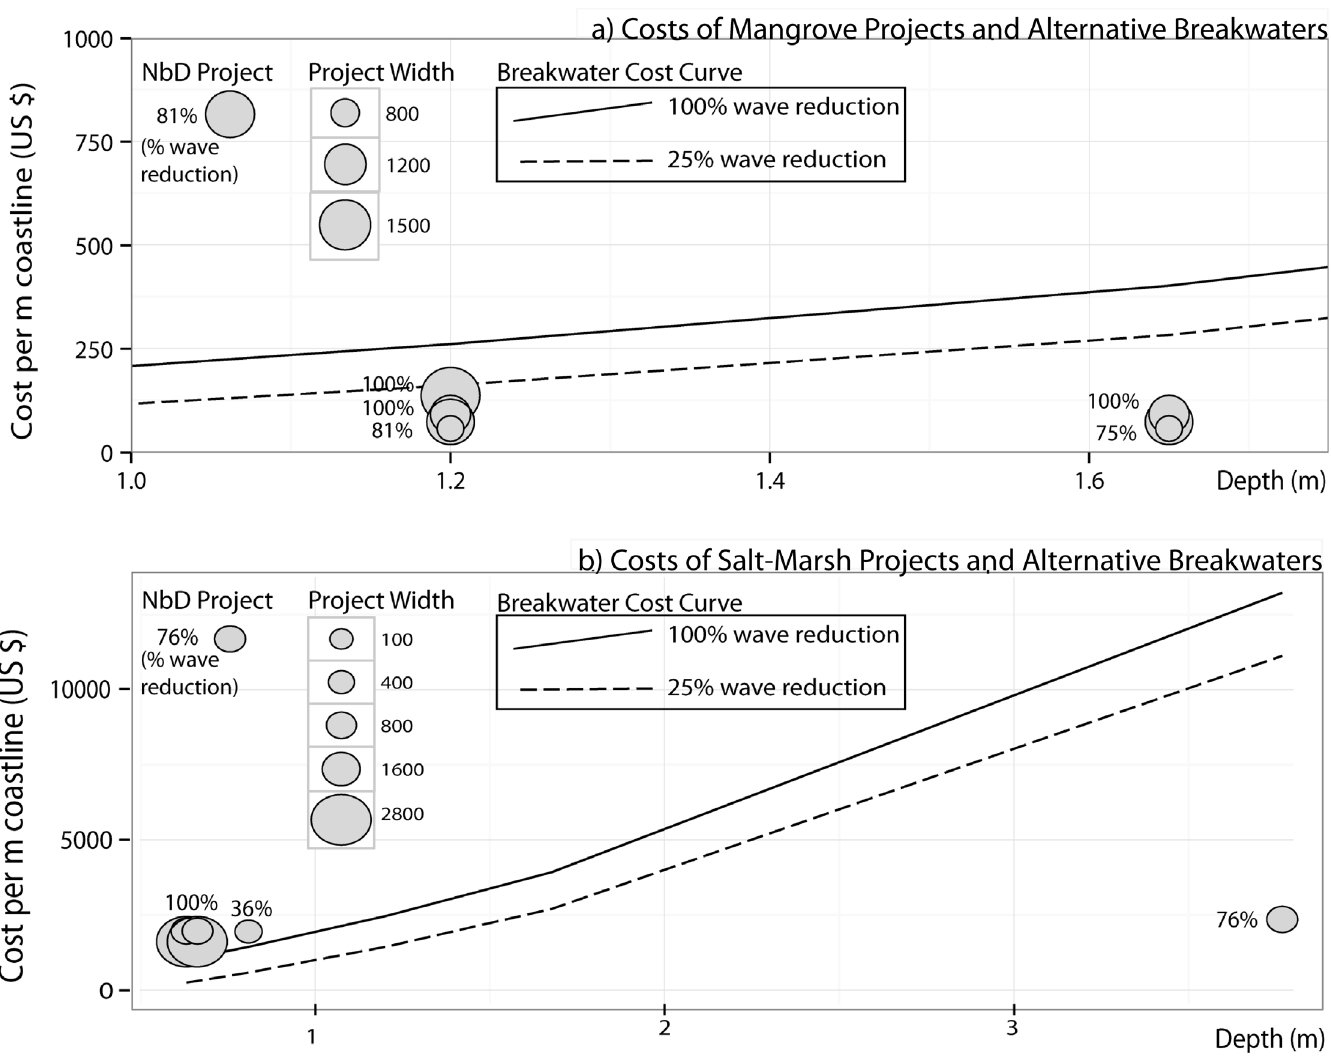
Fig 3. Costs versus water depth and wave height reduction extents of Nature-based Defence (NbD) projects and alternative breakwaters. Costs of NbDs and cost curves of alternative breakwater structures plotted versus water depth are plotted for a) mangroves (n = 7) and breakwaters in Vietnam and; b) salt-marshes (n = 6) and breakwaters in Europe/USA. Circles represent NbDs and lines represent submerged breakwaters cost-curves in both panels. NbDs that fall below breakwater cost curves are cost effective in comparison. Breakwater cost curves are for an incident wave height Hsi of 0.2 m. All costs are represented on a per-metre coastline length basis (see Methods). Fig only shows mangroves and marshes as these were the only habitat types and locations for which project information was found in close proximity to field measurements.